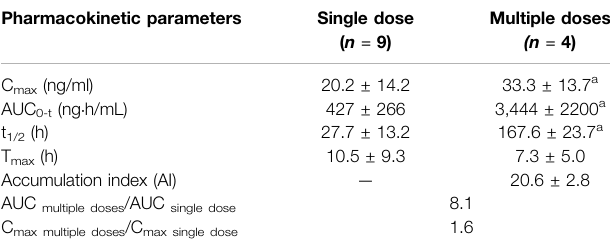
TABLE 1 | Pharmacokinetic parameters of total arsenic in human blood after single and multiple oral doses of NHJDT (Mean ± SD). Pharmacokinetic